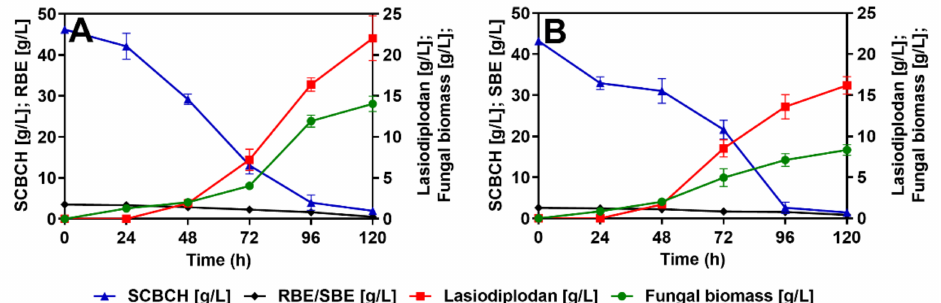
Figure 5. Production of lasiodiplodan and fungal biomass by L. theobromae under optimized culture